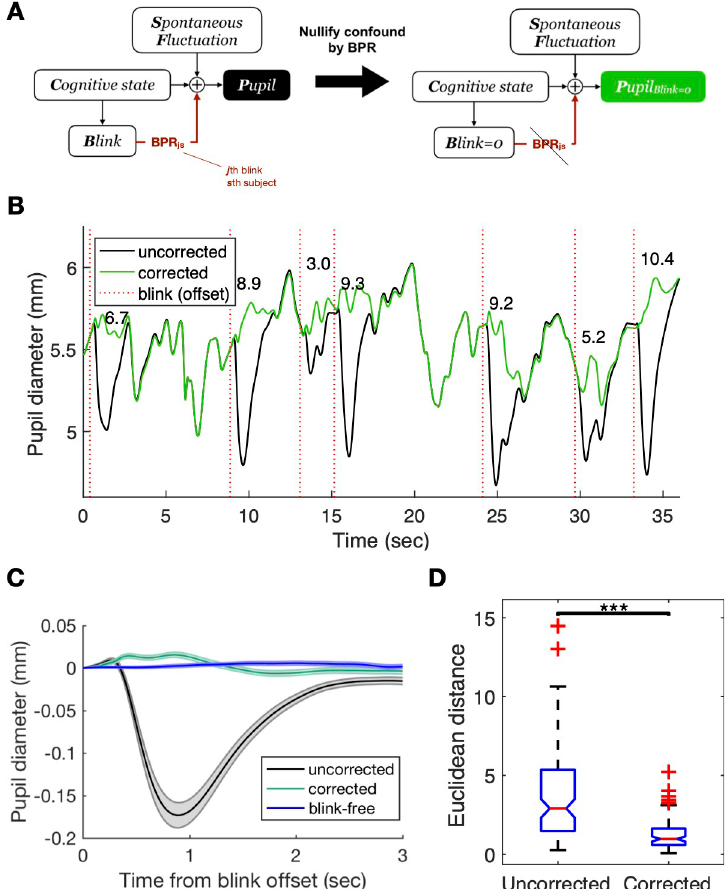
Fig 4. Generative model-based decomposition of pupil-size measurements and example correction result. ( A ) According to the realistic model, observed pupil size is an amalgam of response to cognitive state, BPR, and spontaneous fluctuation from other cognitive-independent sources. The goal is to decompose the pupil size as the sum of the components with a generative model and eliminate BPR specifically based on the estimated BPR component, making the data free from BPR confound. The algorithm estimates the BPR shape for each subject and BPR amplitude for each blink (e.g., s th subject’s j th blink is estimated here) (see Materials and Methods for the detailed description of the algorithm). ( B ) An example of BPR correction results. Note that the correction algorithm estimates the BPR amplitude for each blink (denoted as numbers above time course) based on the generative model. ( C ) Comparison between blink-locked time course from pre-BPR correction (black), post-BPR correction (green), and blink-free period (blue). Note that the characteristic short-pipe shape of BPR before correction is flattened and resembles a blink- free period after being corrected for BPR. Line and shade indicate the mean and standard errors of the mean (SEM), respectively. ( D ) Euclidean distance between the mean blink-locked time course and the mean blink-free time course in each subject. The distance decreases significantly after BPR correction ( p < 0.001; ���